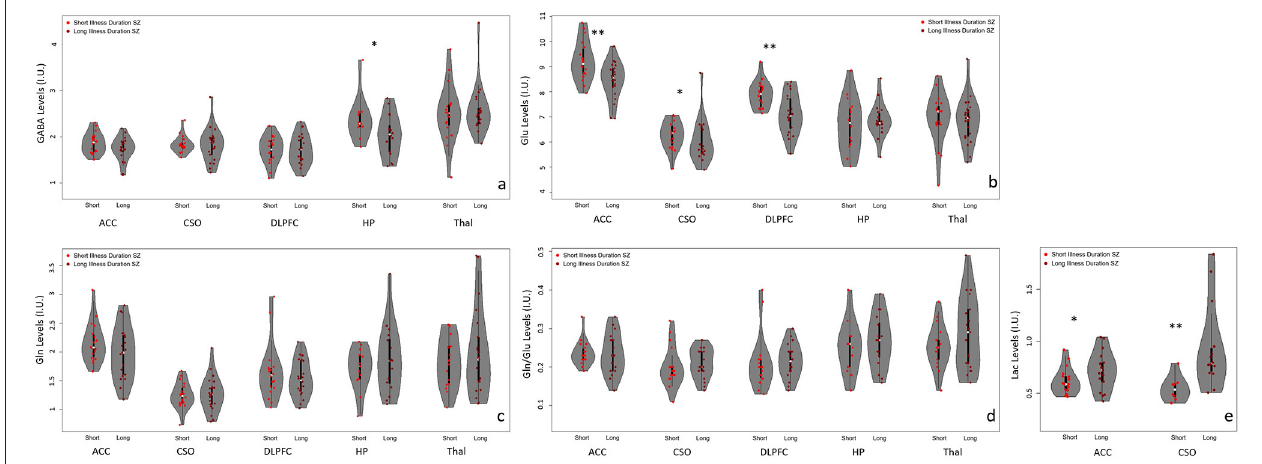
FIGURE 4 | Violin plots with individual data points summarizing the significant (** p < 0.05) and trend level (* p < 0.1) differences between adults with SZ with short ( ) and long illness ( ) durations in the anterior cingulate cortex (ACC), left centrum semiovale (CSO), left dorsolateral prefrontal cortex (DLPFC), left hippocampus (HP), and bilateral thalamus (Thal). (a) There was a trend level difference in GABA in the HP such that GABA was higher in the short illness duration group compared to the long illness duration group. (b) Glu levels were significantly higher in the short illness duration group vs. the long illness duration group in both the ACC and DLPFC. A similar relationship, but at trend level, was observed in the CSO. (c,d) There were no significant relationships between groups across all regions for Gln and Gln/Glu. (e) For Lac, there was a significant difference in the CSO such that the long illness duration group had higher Lac levels compared to the short illness duration group. A similar relationship was observed in the ACC but at trend